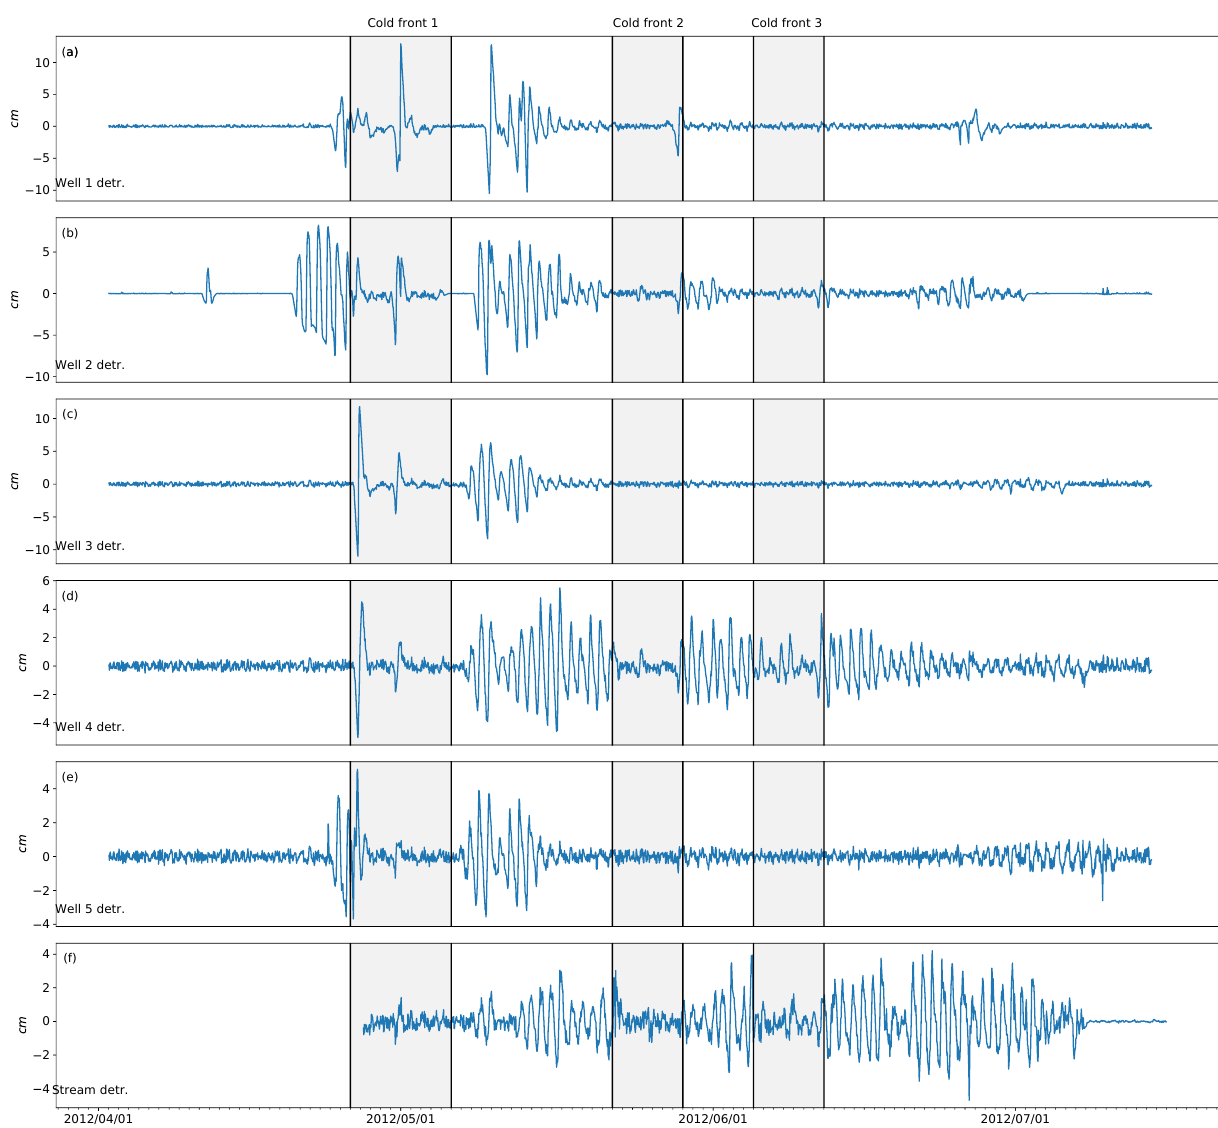
Figure 3. Detrended water levels for wells 1 to 5 (a–e) and for the stream (f) during the melt season. The grey shaded area indicates three major cold storms during the study